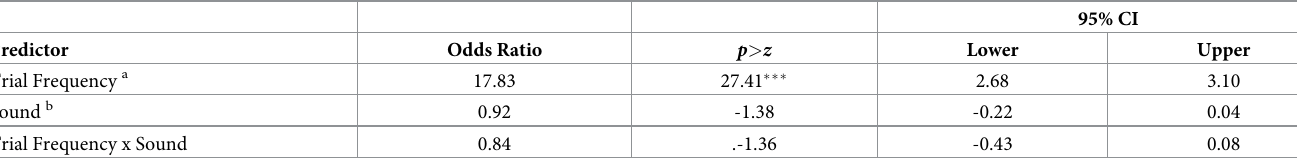
Table 5. Logistic regression of error rates predicted by trial frequency and sound condition.